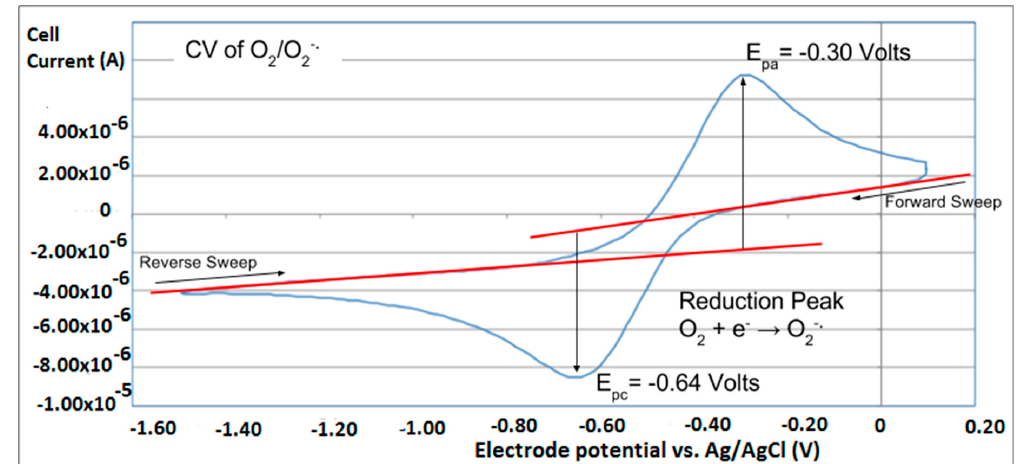
Figure 1. Cyclic voltammogram of dioxygen/superoxide redox couple.